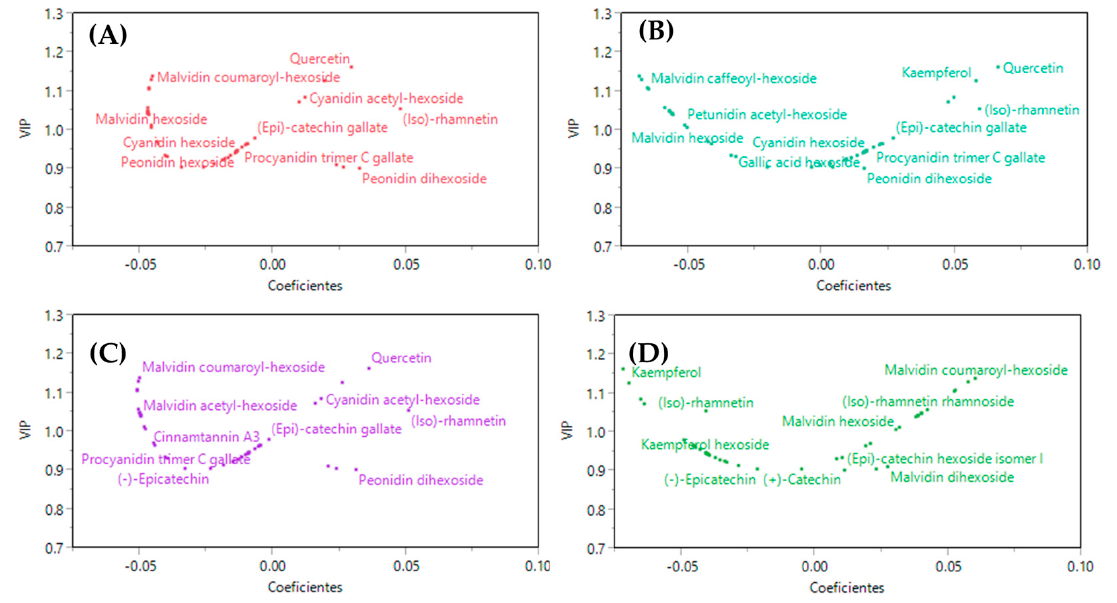
Figure 5. Partial least squares discriminant analysis PLS-DA of the phenolic profile of grape pomace varieties and ( A ) triglycerides in serum, ( B ) weight increase, ( C ) AUC from OGTT, and ( D ) mesenteric adipose tissue.